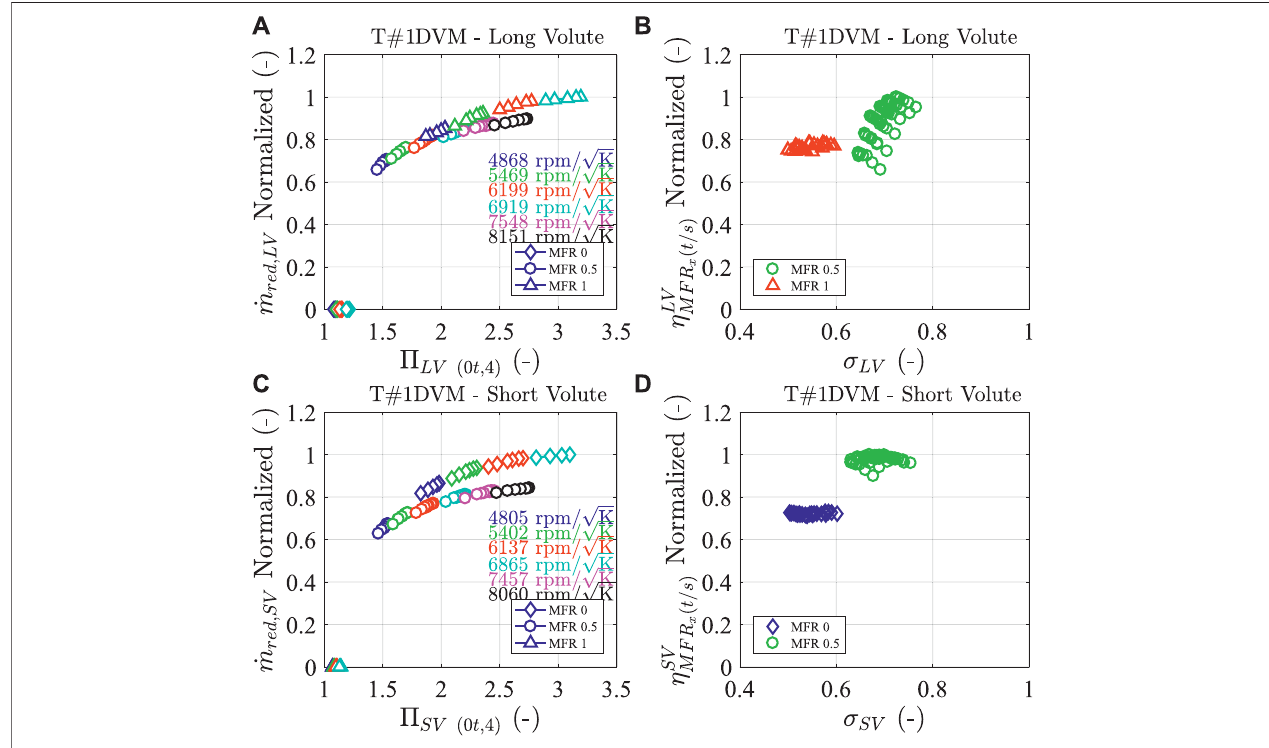
FIGURE21| Turbinemass fl owandapparentef fi ciencymapsofdual-volutemixed fl owturbinetestedunderfull(MFR0.5)andpartial(MFR0and1) fl owadmission conditions in the gas stand, Samala